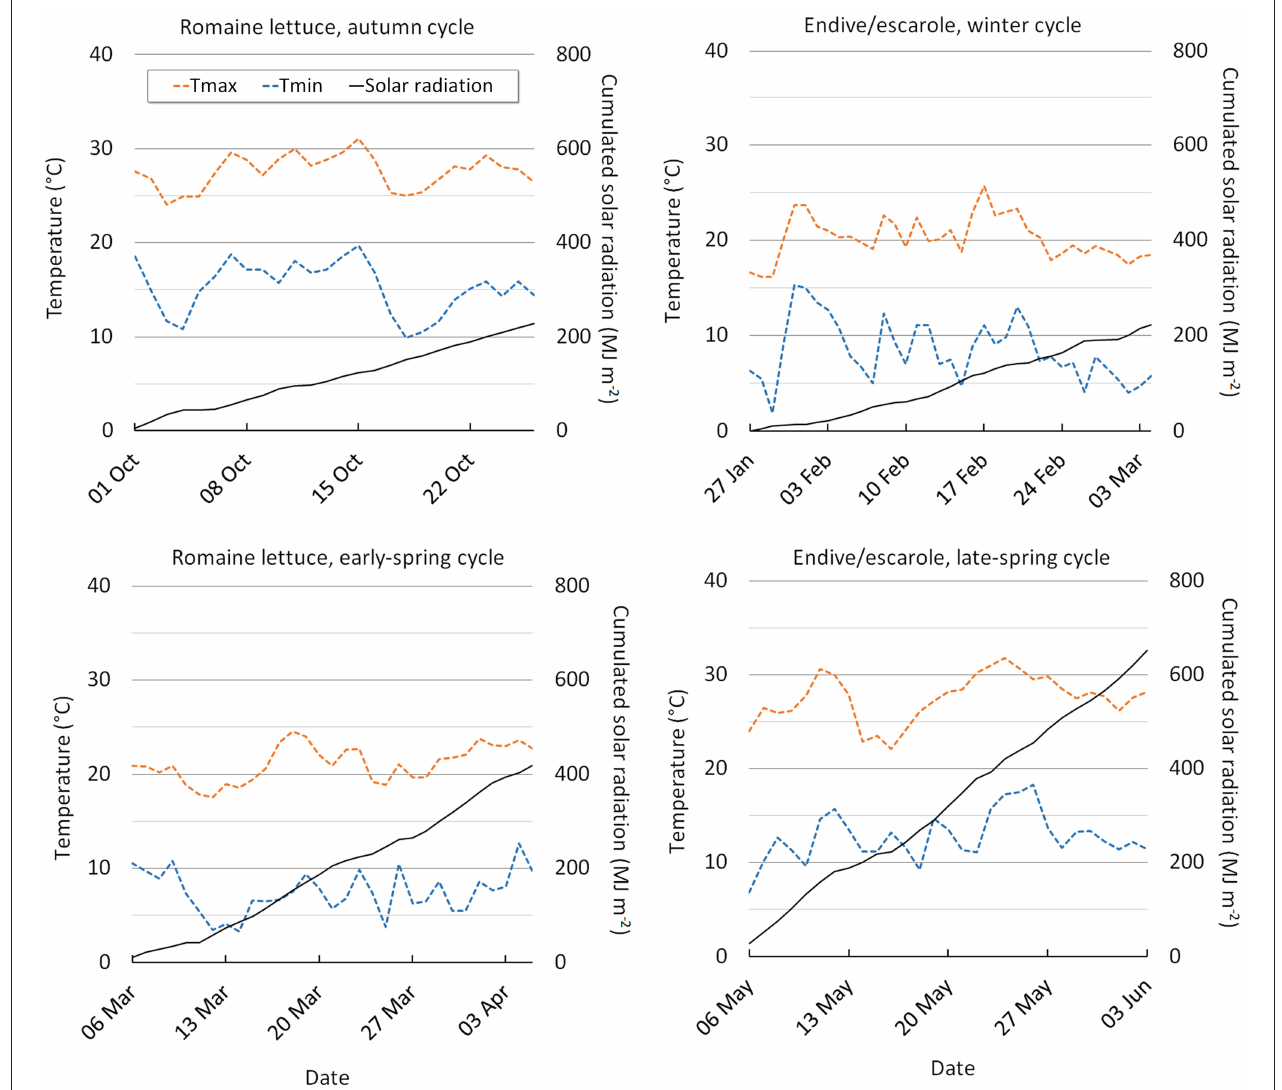
FIGURE 1 | Internal greenhouse minimum and maximum air temperature, and cumulated solar radiation during the autumn, early-spring (lettuce), winter and late-spring periods ( C. endivia ).